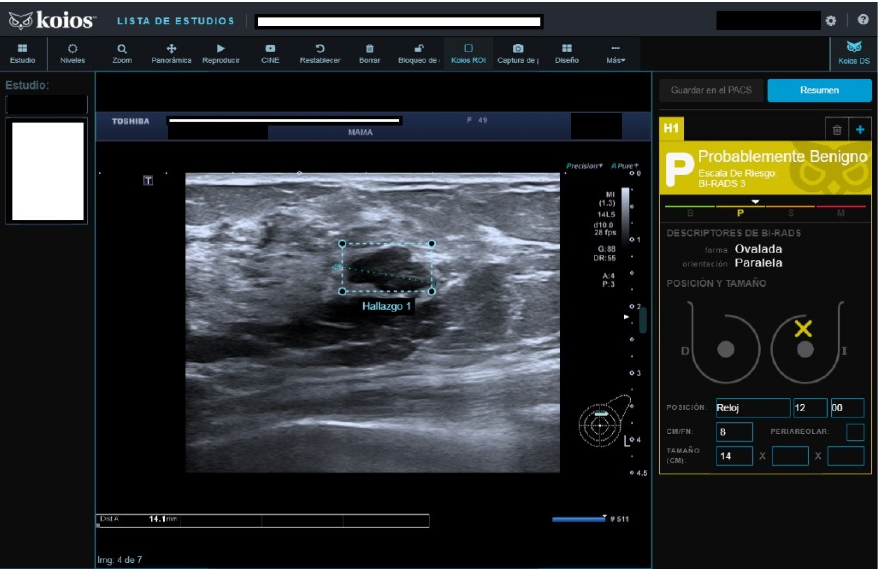
Figure 3. Nodule rated B3 by reader, Kpb by KOIOS. Cytology reported fibroadenoma with simple hyperplasia; biopsy rendered a fibroadenoma diagnosis.